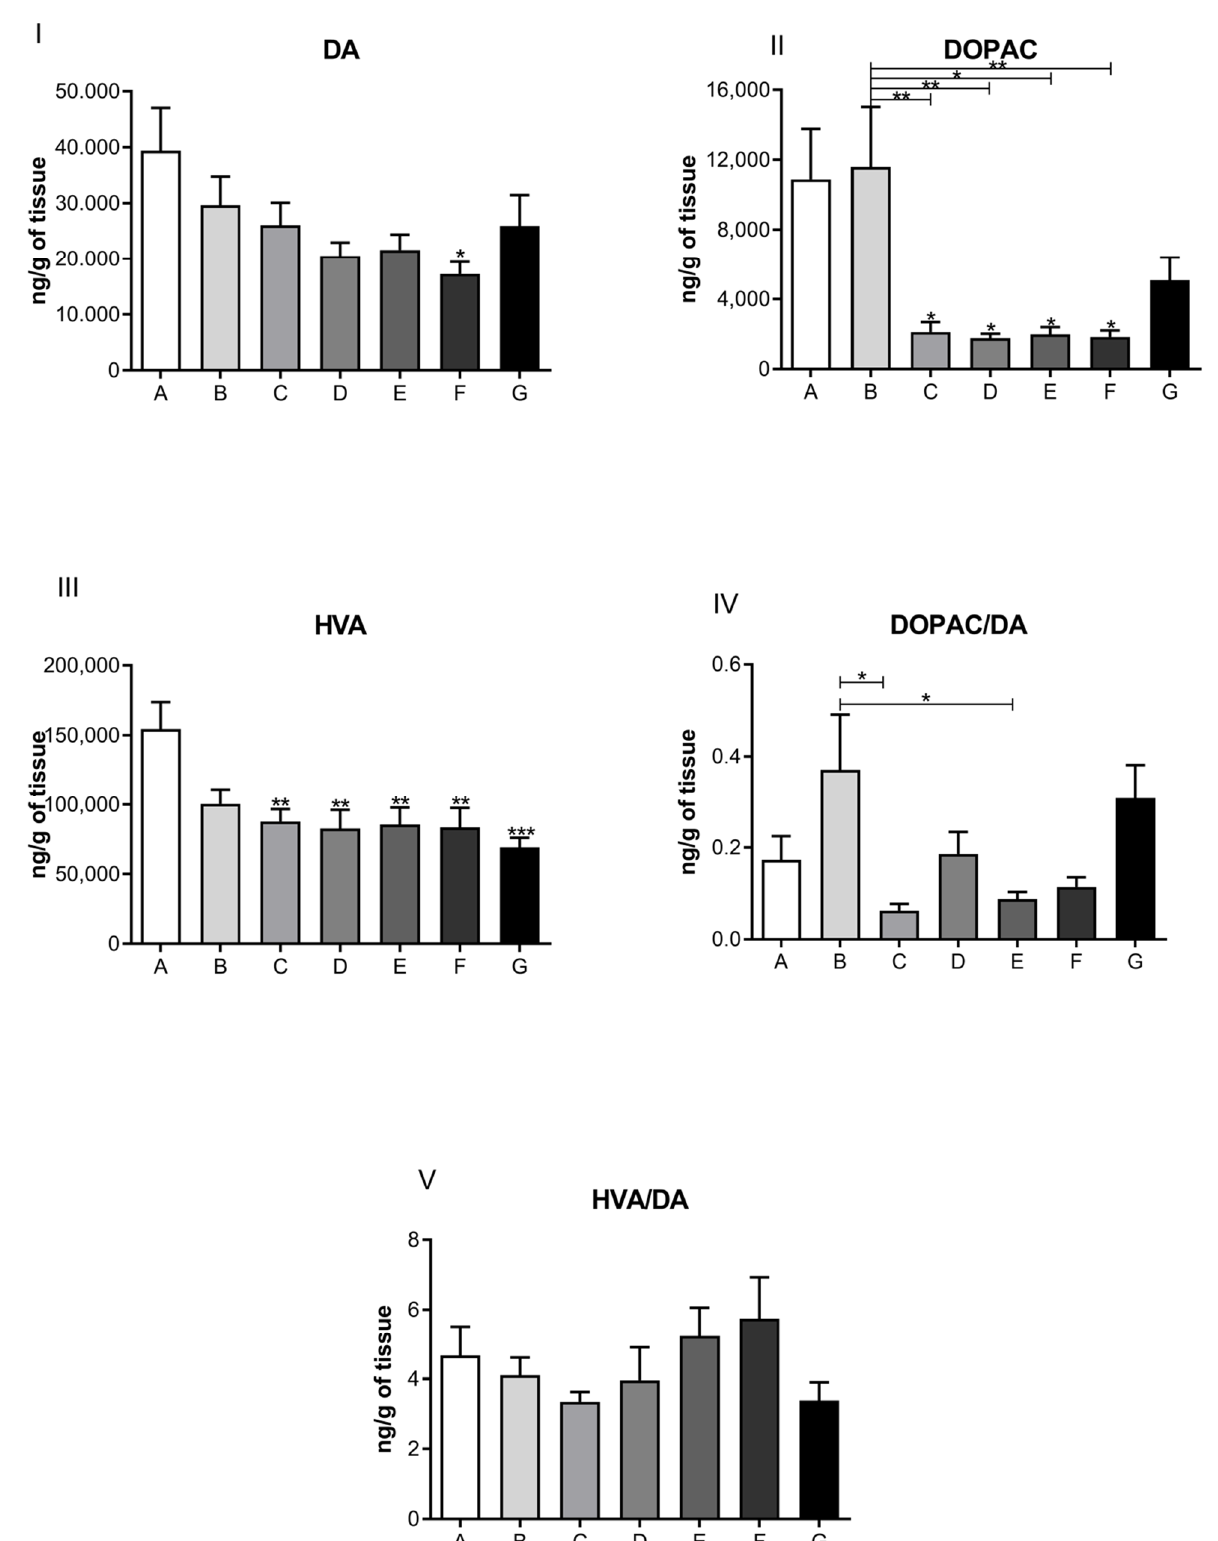
Figure 4. Neurotransmitter levels related to the dopaminergic system in the cardiac muscle of rats submitted to the postpartum separation depression model, treated or not with different doses of ketamine intraperitoneally. Panel ( I ): Dopamine levels (ng/g); Panel ( II ): 4,4-dihydroxyphenylacetic